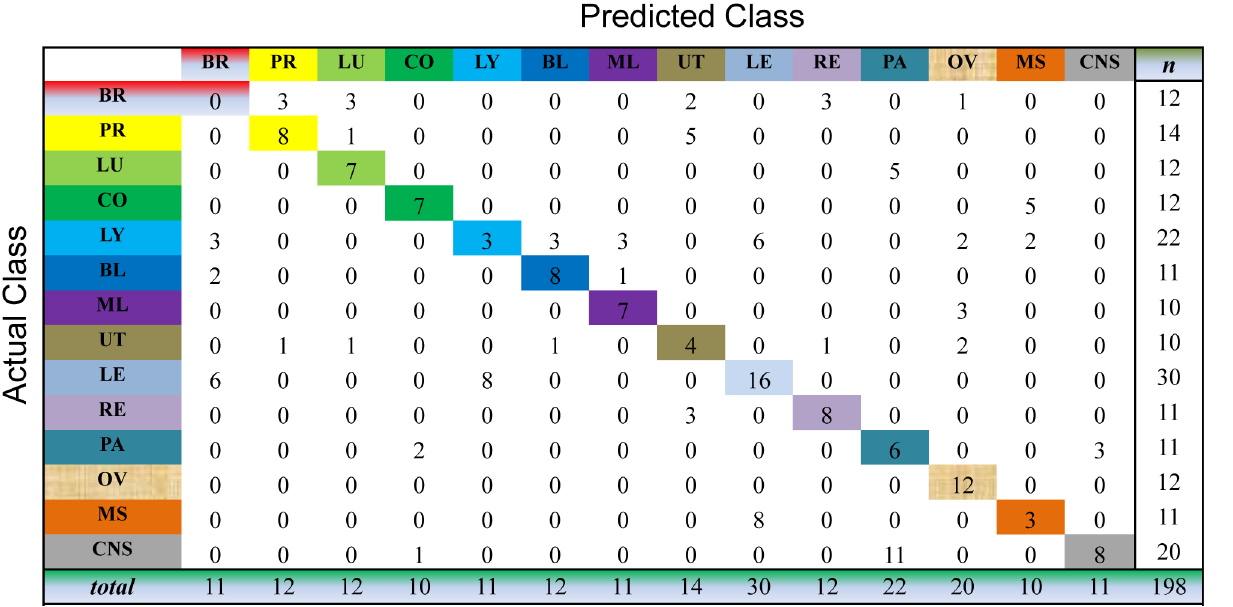
Fig 7. Confusion matrix of prediction results using TSVM, which achieves a total accuracy of 48.99%. Matrix delineates distribution of actual compared with predicted class membership for multiclass cancer prediction on the GCM dataset.